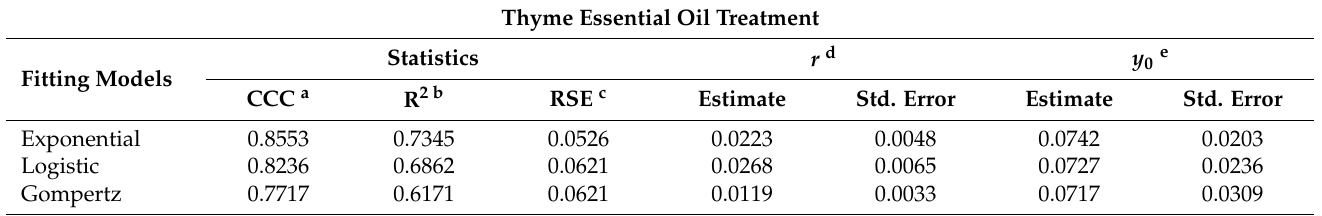
Table 3. Parameters estimated by nonlinear regression with different epidemiological models fitted to the progress of tomato early blight disease caused by Alternaria linariae .